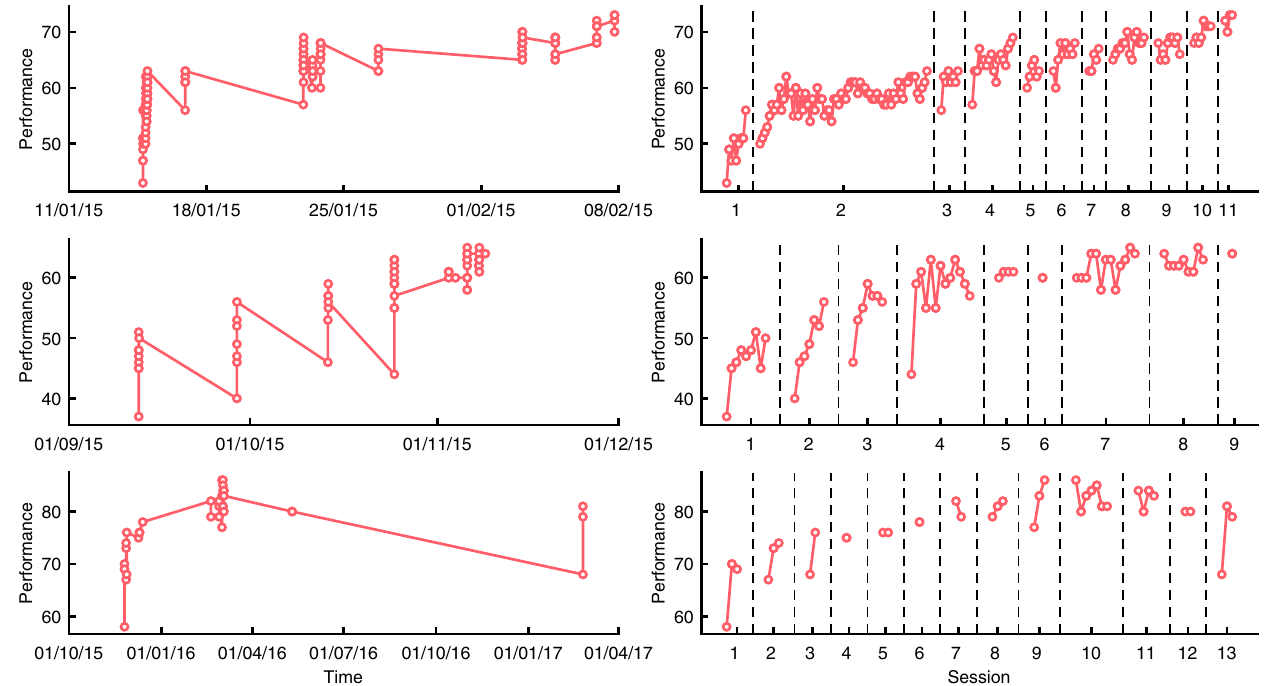
Fig. 1 Example learning curves for three individuals in the Lumosity data set (rows). In the left panels, time is expressed as the date and time stamp at which each gameplay occurred. Circle markers indicate individual gameplays. Right panels show time expressed as session and gameplay within session. Performance is assessed by the number of correct decisions within one gameplay (see Methods for details).